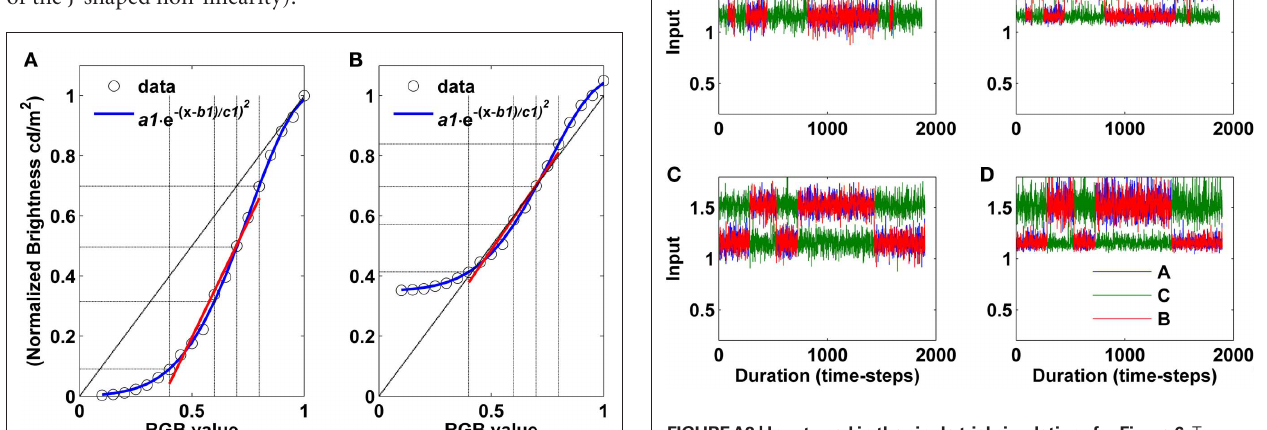
Figure A2 | input used in the single trial simulations for Figure 6. Top panels show input starting with alternatives [ (A,B) (as the top panels in Figure 6 ) while bottom panels input starting with alternative (C) . Left shows the original input while right the transformed input (according to the fitted function of Figure A1 right